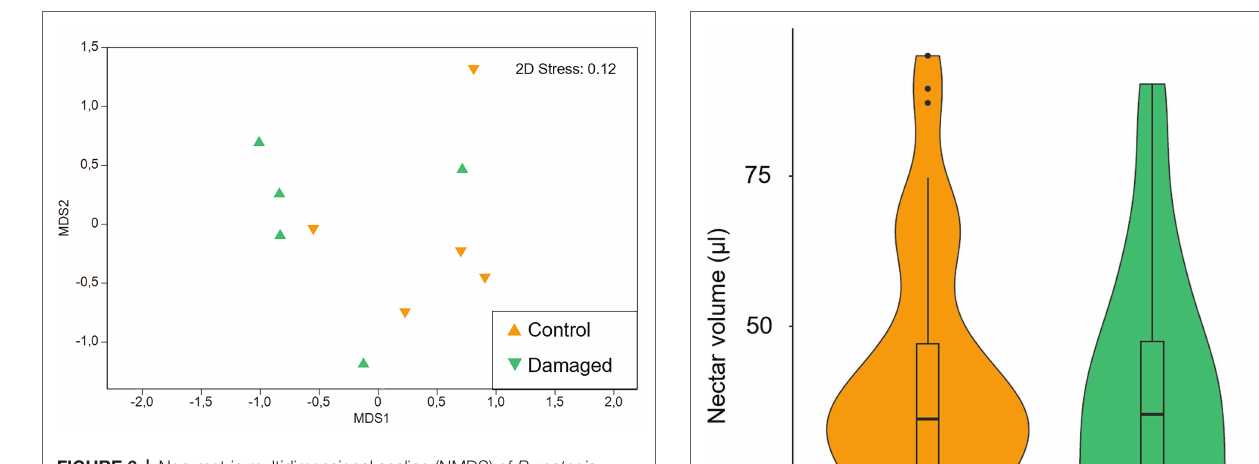
FIGURE 6 | Non-metric multidimensional scaling (NMDS) of Pyrostegia venusta floral scent from control and naturally damaged flowers. Comparison between the relative scent composition emitted by flowers that were intact (control) or naturally damaged by the florivore caterpillar, Parrhasius polibetes (black-spot hairstreak, Lycaenidae). There was no significant difference in relative scent composition among flowers submitted to both treatments (PERMANOVA with 9,999 permutations, Pseudo-F [1, 2.06] = 2.06; p = 0.20). Each dot represents a sample.